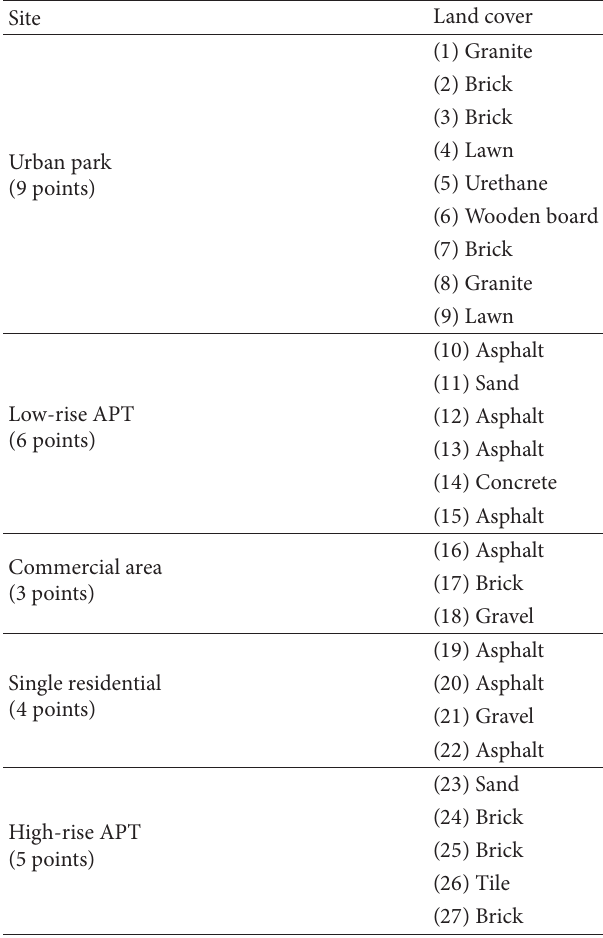
Table 1: Characteristics of land cover at the measure points.